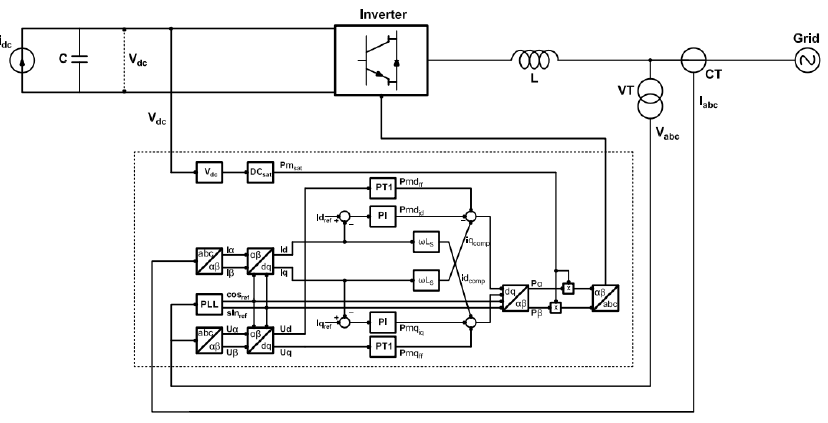
Figure 3. PV-inverter block diagram.